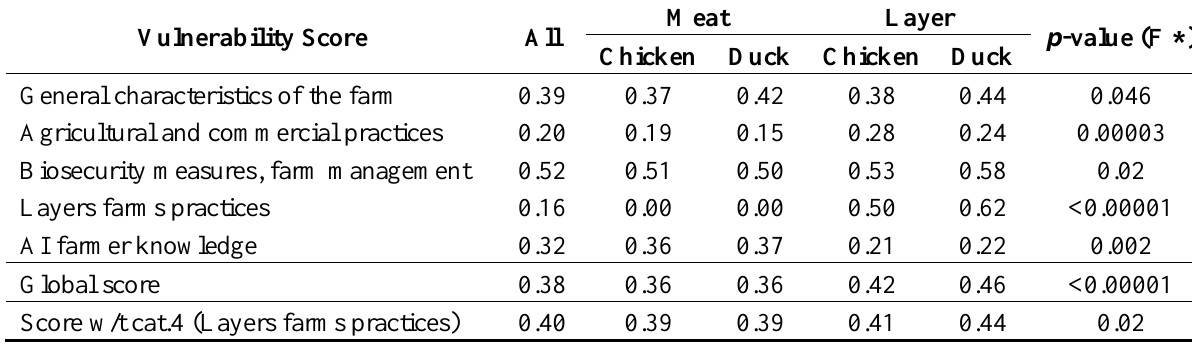
Table 6. Analysis by poultry type and production type.